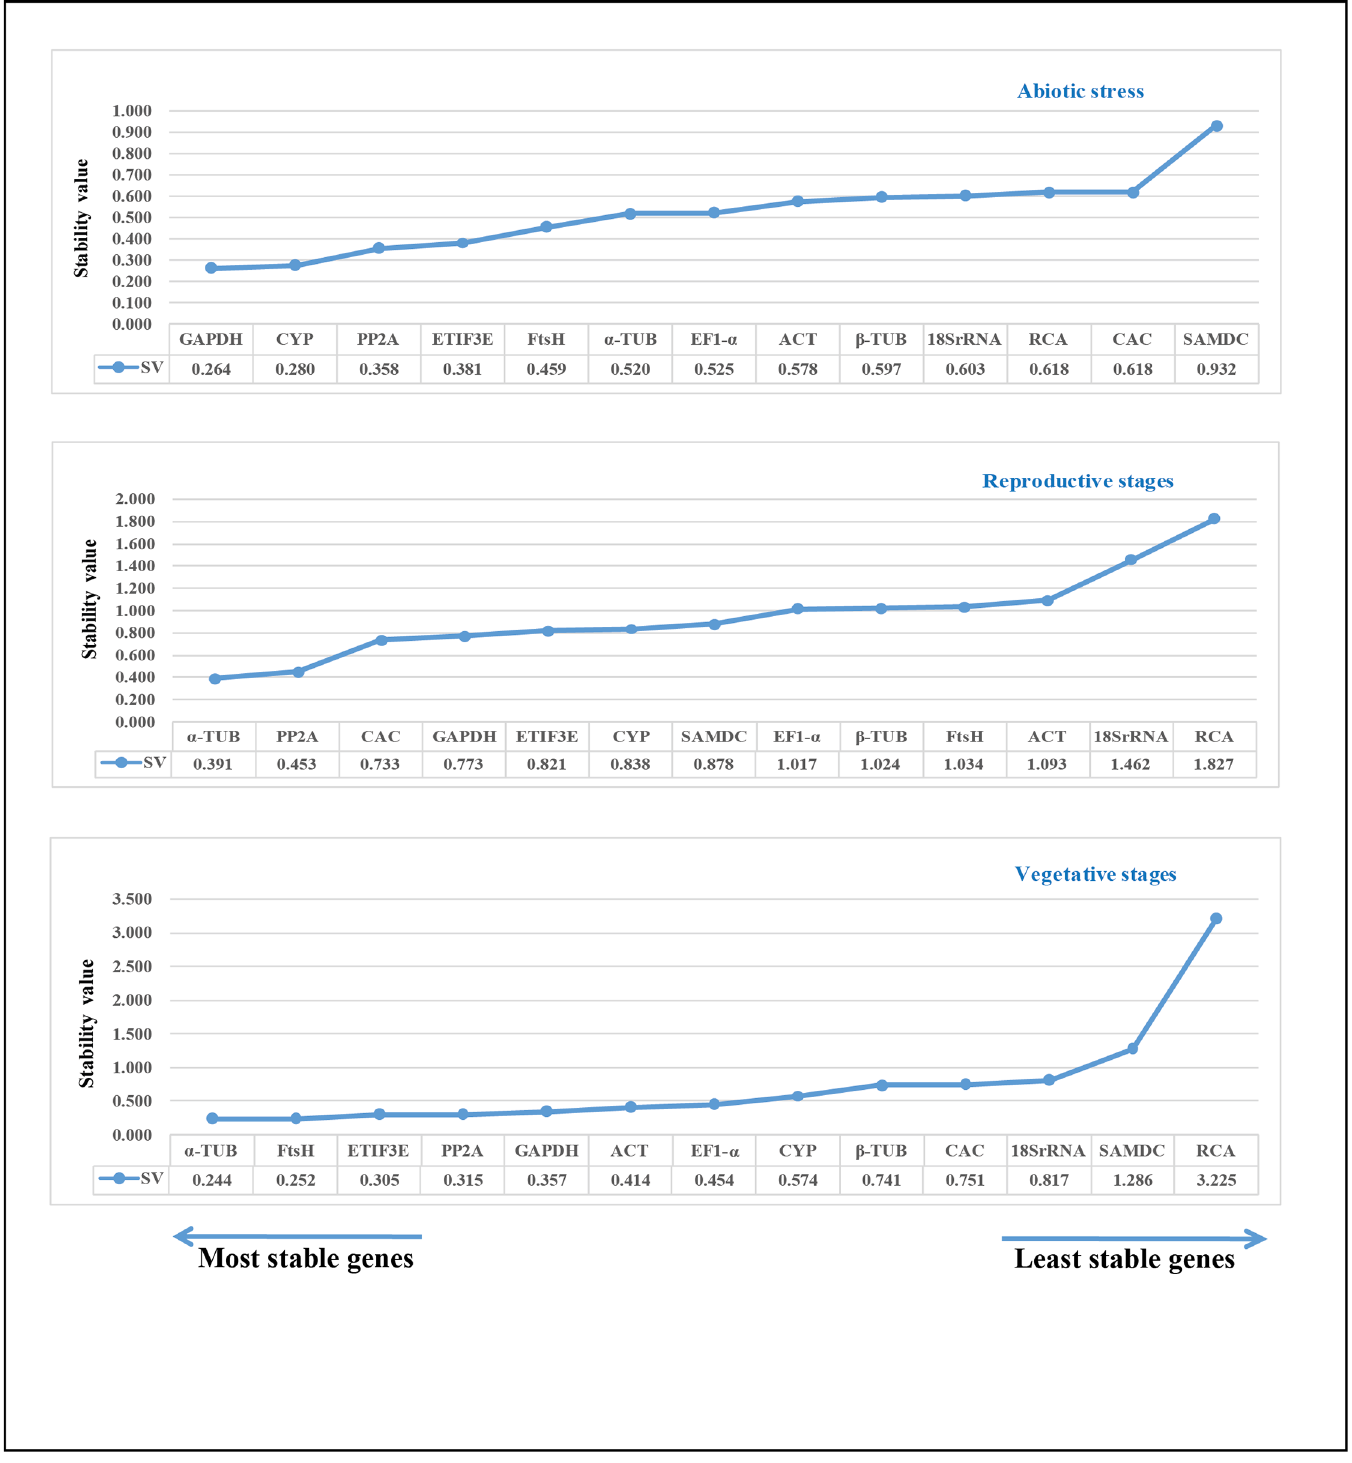
Fig 5. Stability values of 13 candidate reference genes across different experimental groups as assayedby Normfinder. Lower stability values indicate highlystable genesand higherstability values indicateless stable genes. The directionof the arrows indicatethe most stable and least stable genes in the graph. The most stable genes are listed on the left and least stable genesare listed on the right.